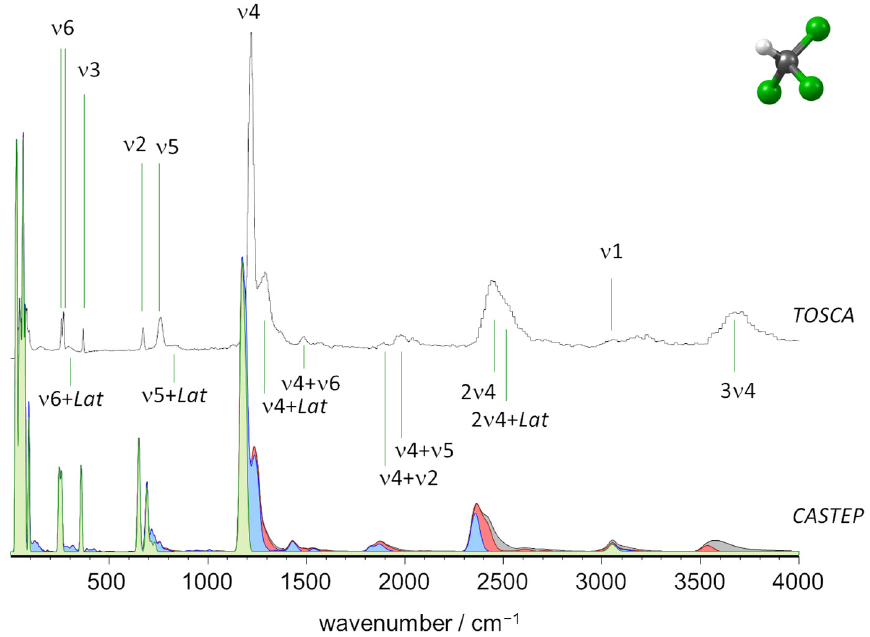
Figure 2. The INS spectra of trichloromethane (chloroform) up to 4000 cm − 1 : Experimental (top, TOSCA) and simulated from periodic calculations (bottom, CASTEP). Colors indicate the intensity contributions from fundamental modes (green), two-quanta events (blue), three-quanta events (red), and higher-order quantum events (grey).